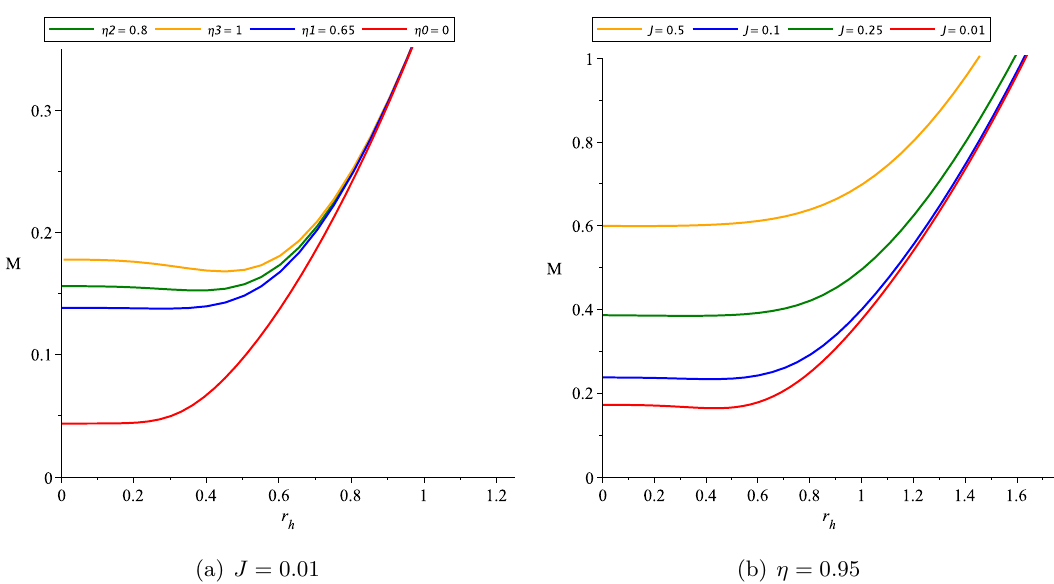
Figure 5 . Variations of mass in terms of horizon radius r h , for the Myers-Perry black hole in five dimensions.